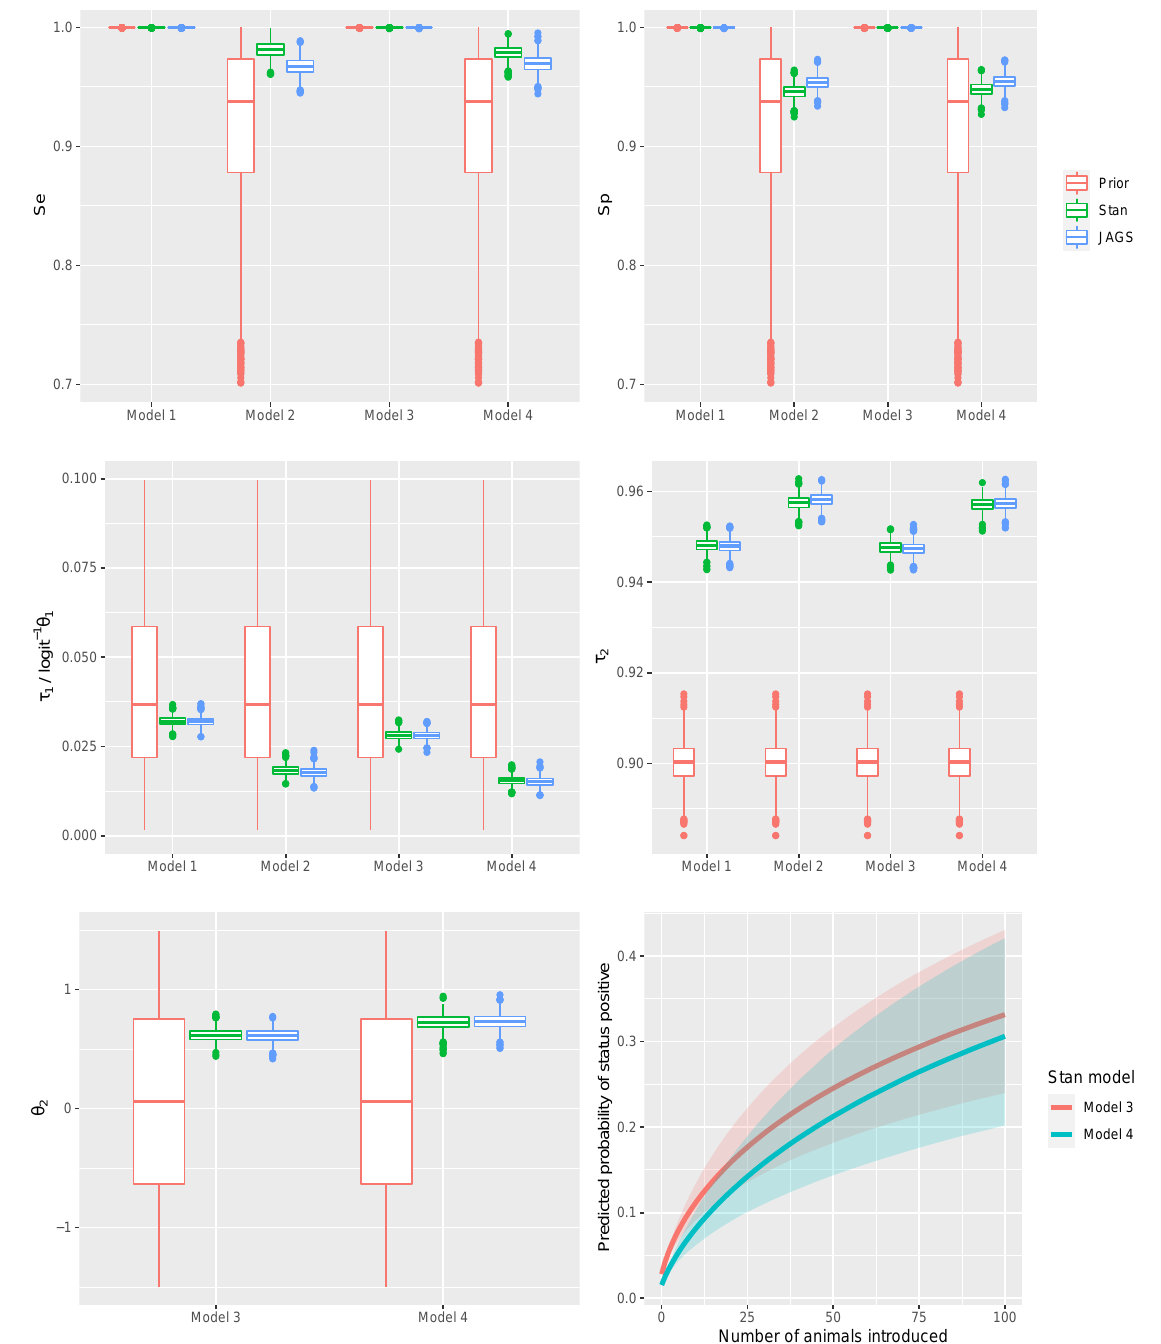
Figure 7 – Parameters prior and posterior distributions for the 4 Bayesian models. Model 1: Perfect test, no risk factor; Model 2: Imperfect test, no risk factor; Model 3: Perfect test, risk factor; Model 4: Imperfect test, risk factor. The only risk factor included is the logarithm of the number of animals introduced + 1. In Models 1 and 2, the probability of becoming status positive is modelled with τ 1 . In Models 3 and 4, the probability of becoming positive is modelled using logistic regression. From these models, logit − 1 τ 1 is the probability of becoming positive when no animal is introduced (i.e. model intercept). τ 2 models the increase in the probability ofbecomingpositivewiththenumberofanimalsintroduced.ThelastrowoftheFigurerepresentstheposterior distributionfor τ 2 aswellasthecorrespondingincreaseintheprobabilityofbecomingpositivewiththenumber of animals